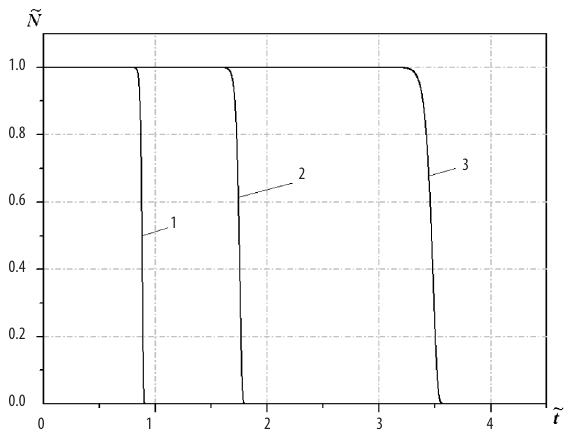
Fig. 1. Dependence of the number of unbroken elements ( ) N t   on the different values of the speed of the load’s application during time. Values of 1/ χτ : 1 – 0 1/ χτ = 100 000; 2 0